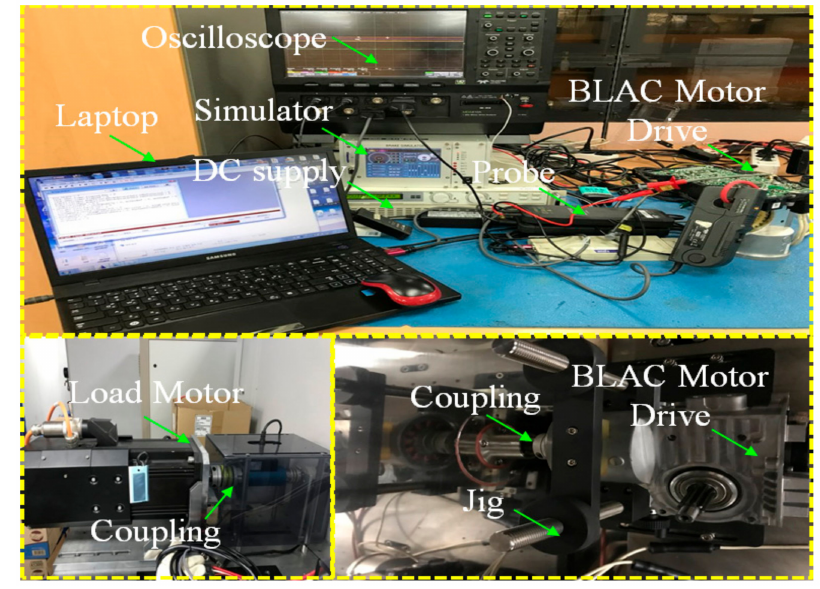
Figure 8. Experimental